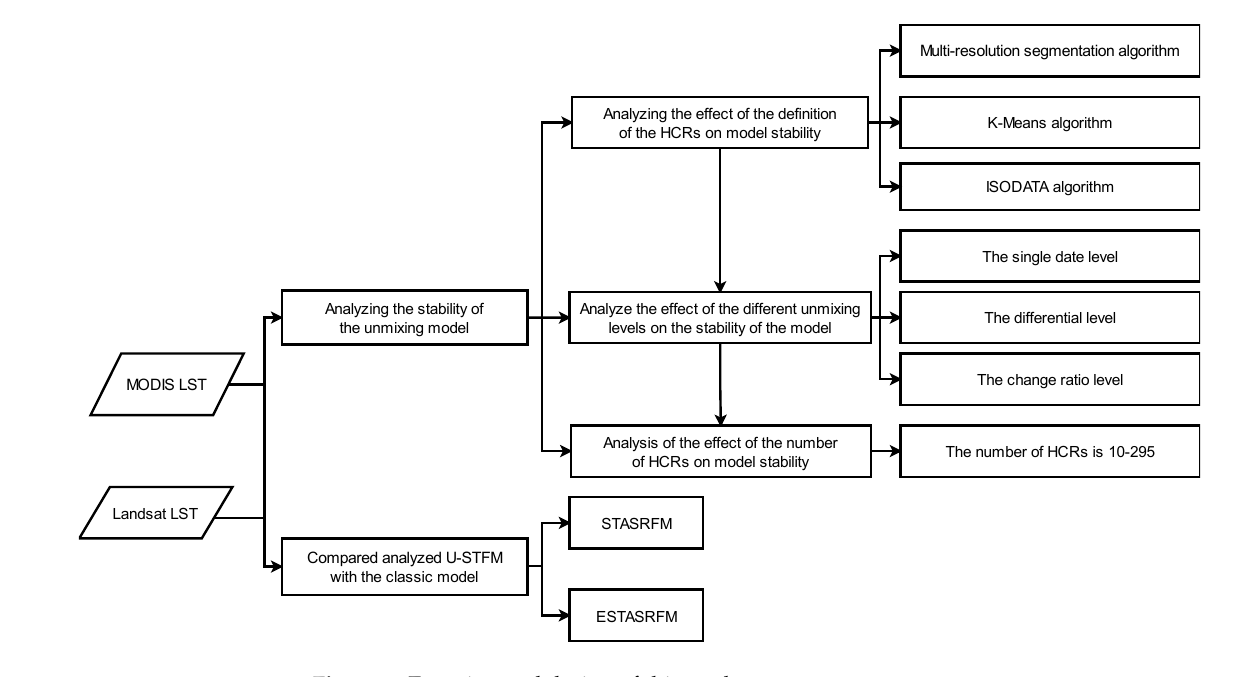
Figure 2. Experimental design of this study.